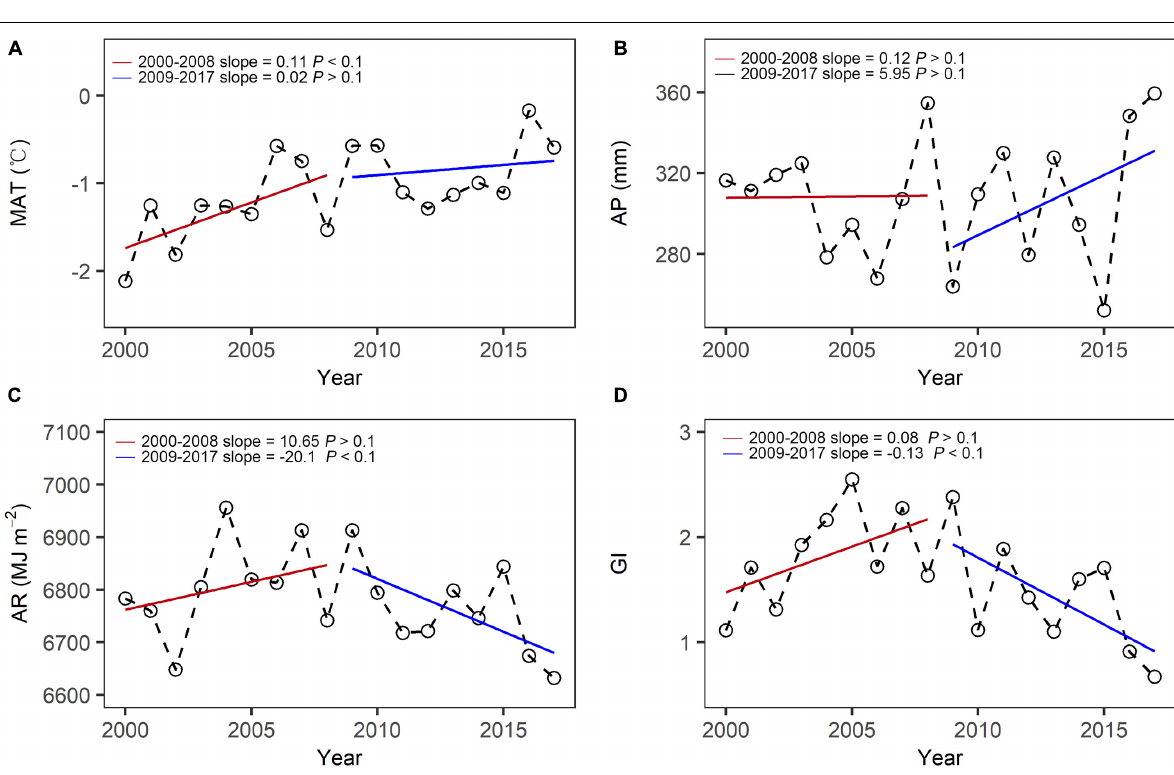
by 5.2%, compared to 27.0 g C m − 2 during 2000–2008. ANPP increased at approximately 81% of grassland pixels ( Figure 5C ). Mean ANPP significantly increased by 2.41 g